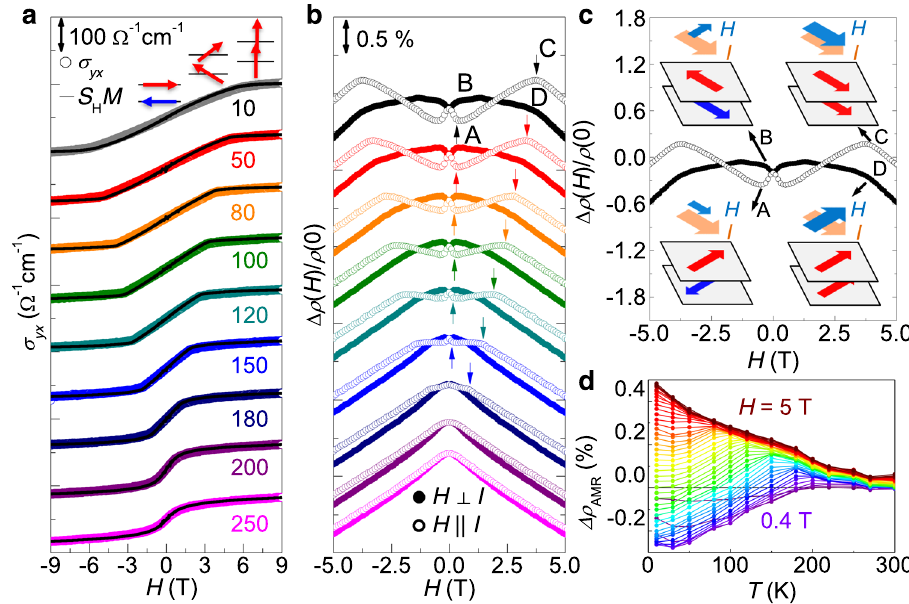
Fig. 4 Electrical detection of the spin states. a The transverse conductivity σ yx ( H ) as a function of magnetic fi elds along the c -axis, taken at various temperatures. The σ yx ( H ) data are nicely reproduced by the fi eld-dependent magnetization M ( H ) (black solid line) with a scaling factor S H ≈ 0.3 V − 1 , following the linear relation of σ yx ( H ) = S H M ( H ). b Magnetoresistance Δ ρ ( H )/ ρ (0) under in-plane magnetic fi elds H , parallel (open) or perpendicular (solid) to the current I along the a -axis. The low fi eld spin – fl op transition fi eld H ab and the high fi eld saturation fi eld H ab are indicated by the arrows. c Spin sf sat con fi gurations with different relative orientations of the magnetic fi eld H and the current I . At low H , the antiferromagnetically coupled spins are aligned perpendicular to H , either H ∥ I ( a ) or H ⊥ I ( b ). At high H , the saturated spins are aligned parallel to H , either H ∥ I ( c ) or H ⊥ I ( d ). d Anisotropic magnetoresistance Δ ρ AMR as a function of temperature and in-plane magnetic fi eld. The low- fi eld and high- fi eld AMR, determined by the relative orientation of Neel vector and the saturated magnetization against the current direction, respectively, which results in a sign